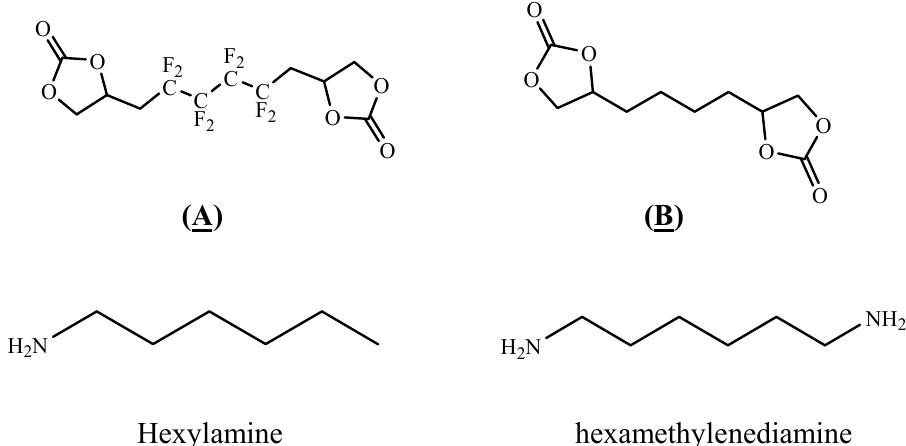
Figure 2. The fluorinated and non-fluorinated biscyclocarbonates ( A & B ) and amines used in this work .